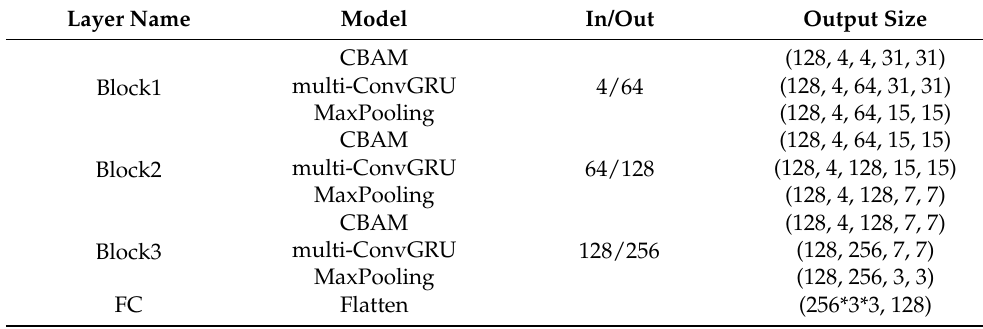
Table 2. The specific model parameters of the Deep model.